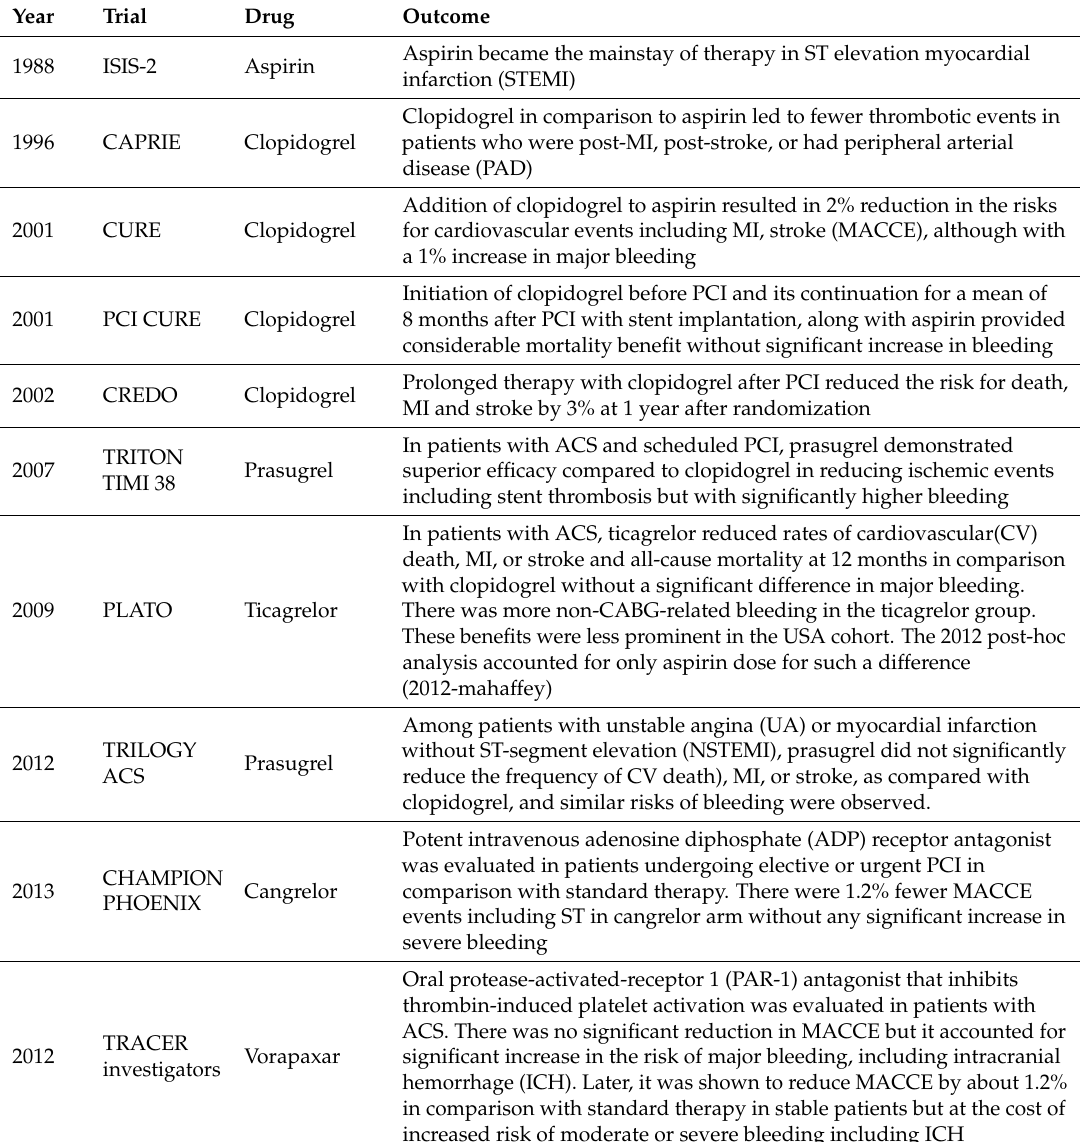
Table 2. Landmark trials of antiplatelet